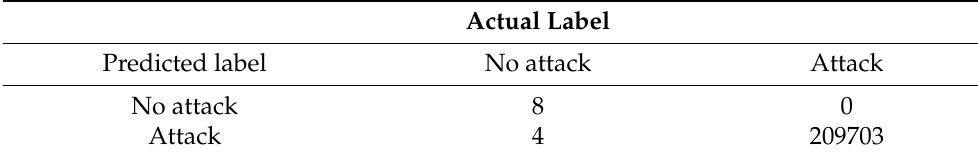
Table 38. DoS UDP NB confusion matrix.